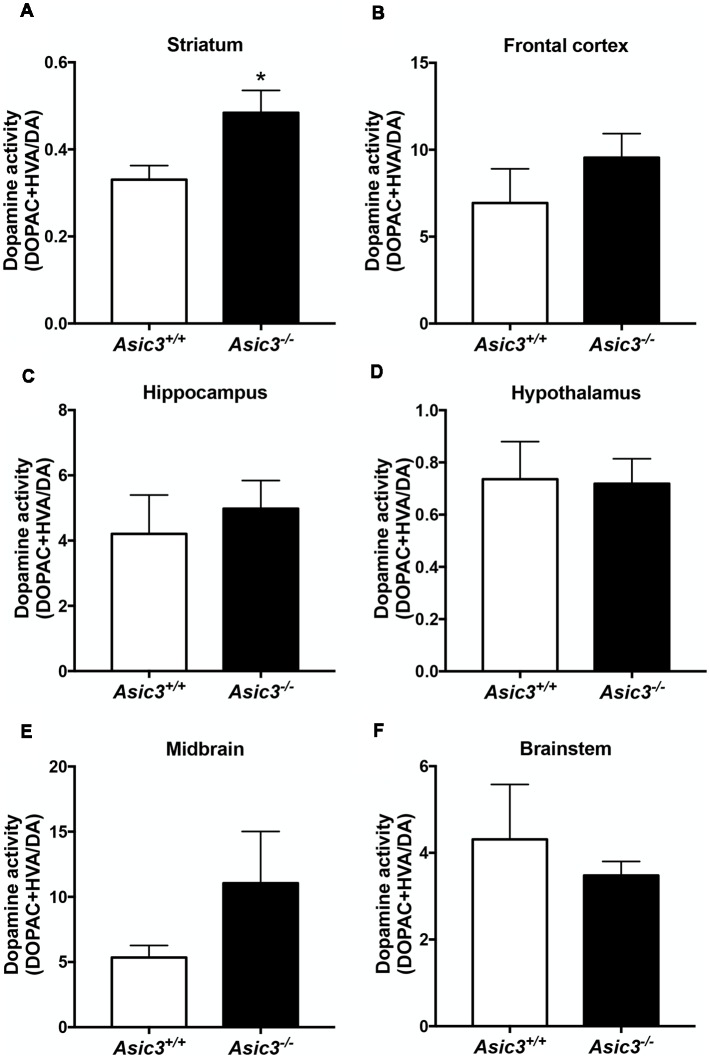
Measurement of dopamine (DA) activity in brain regions in Asic3−/− mice. (A) The DA activity [(DOPAC+HVA)/DA] was increased in striatum in Asic3−/− mice as compared with Asic3+/+ mice: t = 2.532, df = 18, p < 0.0209; *p < 0.05. No difference was detected between Asic3+/+ and Asic3−/− mice in (B) frontal cortex, (C) hippocampus, (D) hypothalamus, (E) midbrain, and (F) brainstem. N = 10 mice per group. Data represent mean ± SEM. Data analyzed by two-tailed unpaired t-test.